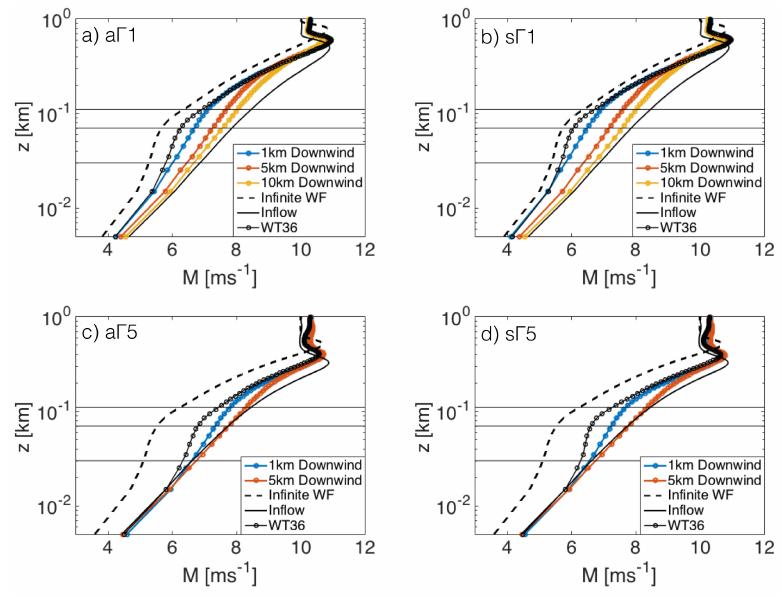
Figure 12. Vertical profiles of time- and spanwise-averaged velocity magnitude at 1 km, 5 km and 10 km downwind of the wind farm, and at the 36th (last) turbine row for the cases: ( a ) FS-a Γ 1; ( b ) FS-s Γ 1; ( c ) FS-a Γ 5; and ( d ) FS-s Γ 5. The solid black profile represents the velocity magnitude of the ABL inflow, and the black dashed profile represents the time- and horizontal-averaged velocity magnitude of the infinite wind farm with the same wind farm configuration. The black horizontal solid lines represent the top-tip, hub and bottom-tip heights.